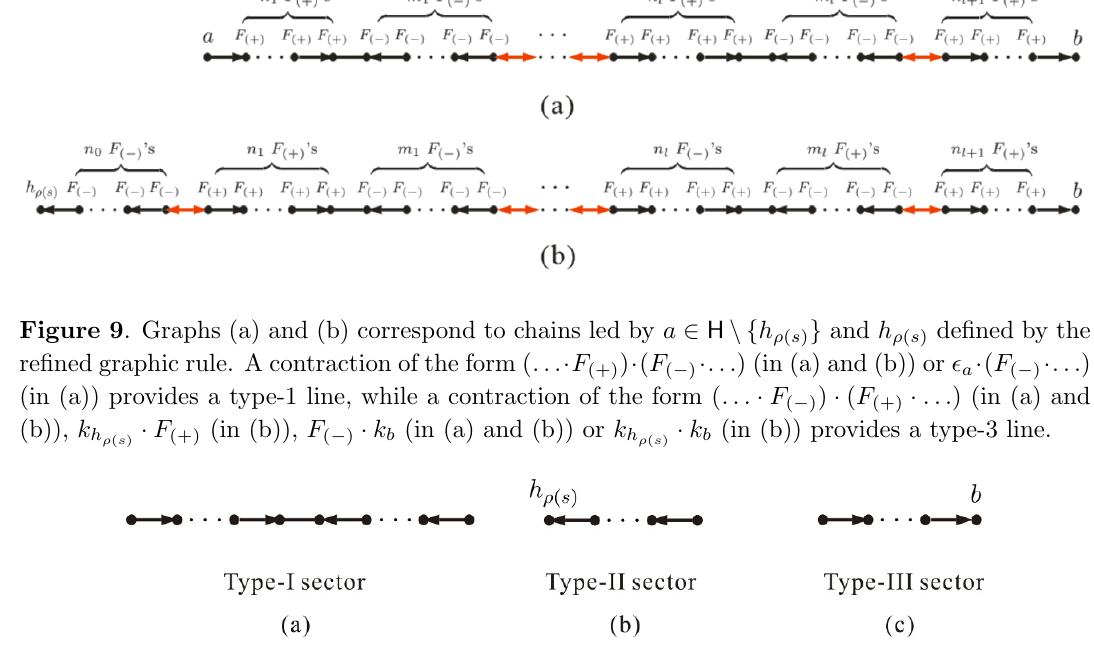
Figure 10 . Three types of sectors of chains when all type-3 lines are